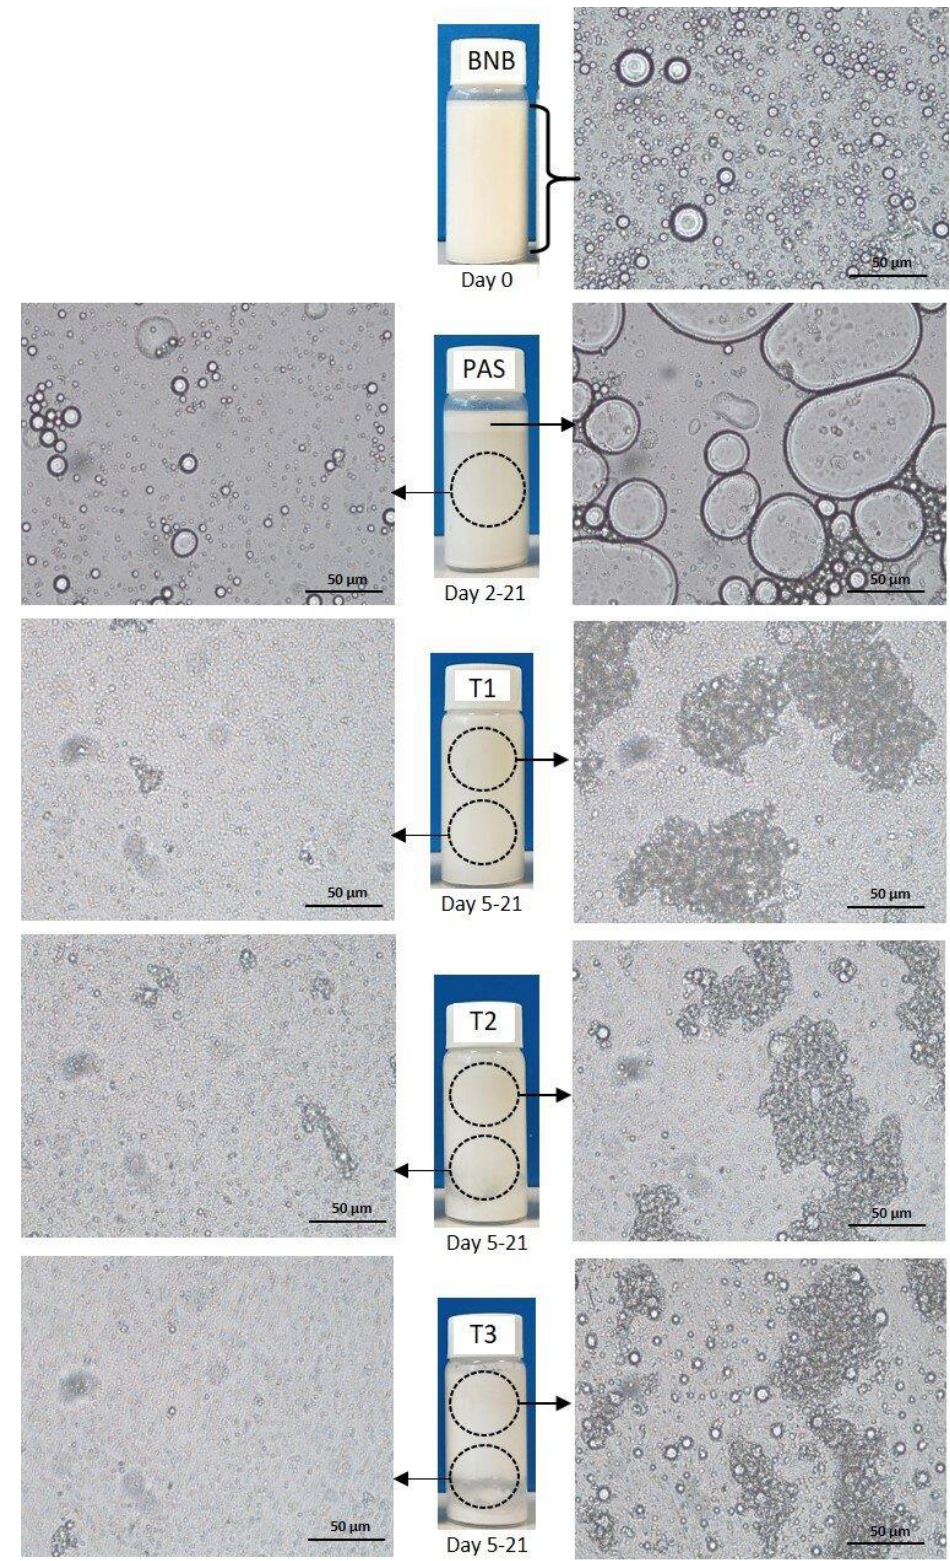
Figure 5. Visual appreciation and optical microscopy of the Brazil nut beverage (BNB) at day 0 and treated with high-pressure homogenization (HPH) and pasteurization (PAS) and stored and preserved at 5 °C for 21 days.